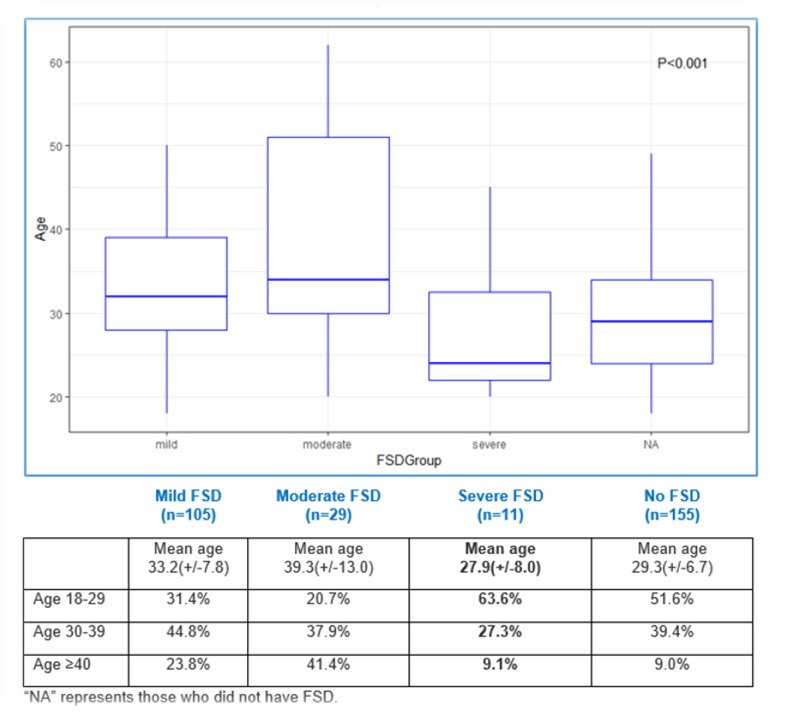
Boxplot of mean age by FSD severity, p<0.001.